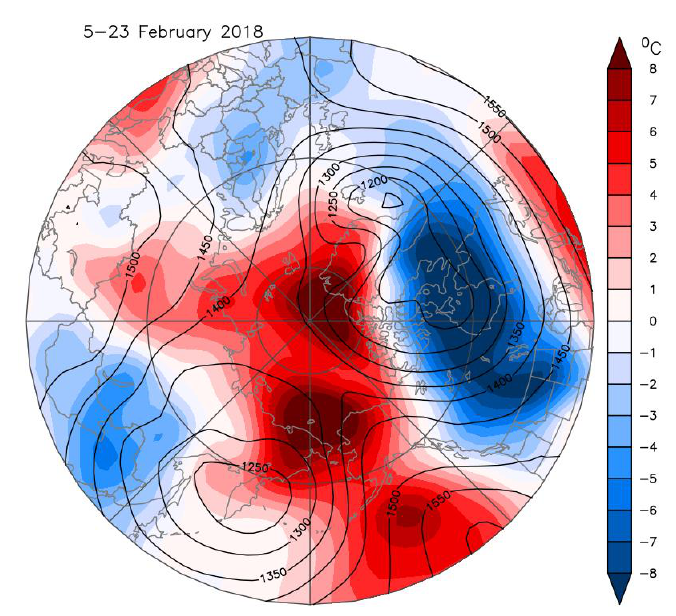
Figure 4. Composite of atmospheric 850 hPa geopotential height (contours in units of meters) and temperature anomaly fields (color shading relative to a 1981–2010 base period) for 5–23 February 2018. Data are from NCEP–NCAR reanalysis.